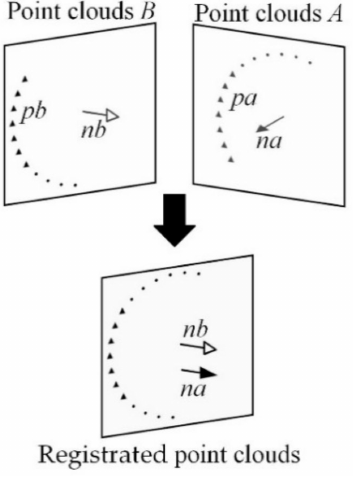
Figure 8. Schematic diagram of point-cloud